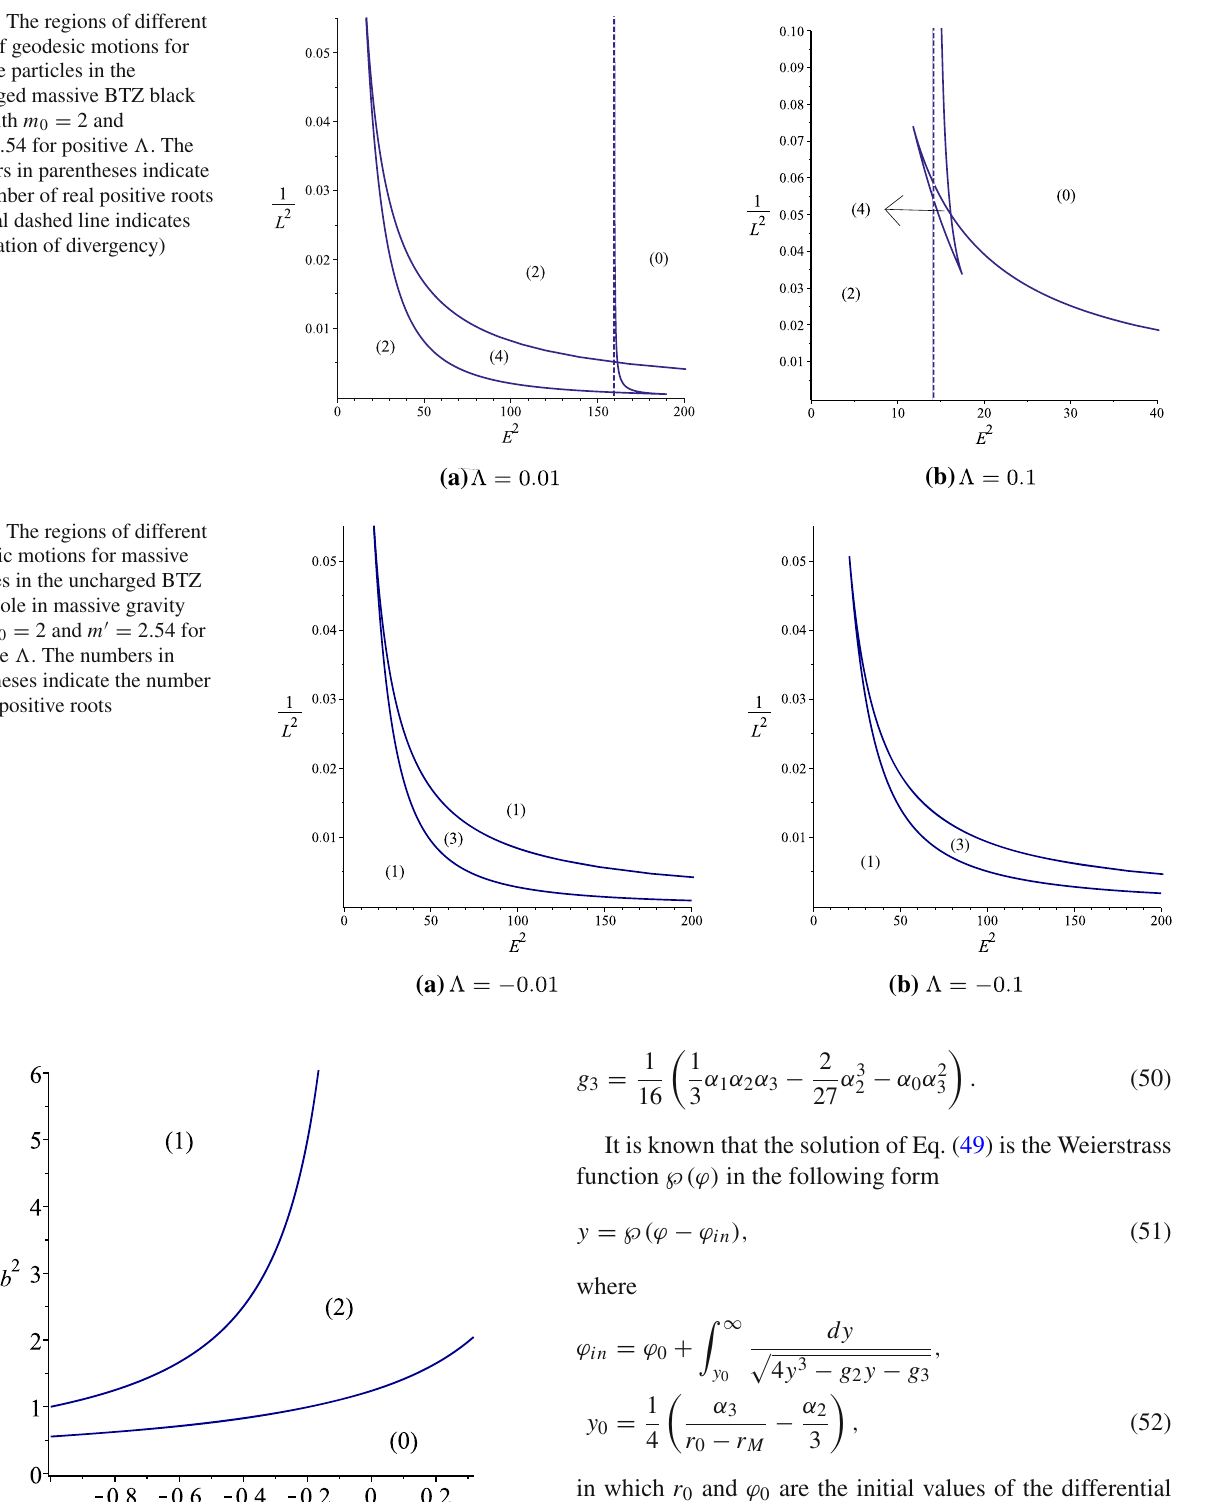
Fig. 8 Theregionsofdifferentgeodesicmotionsformasslessparticles in the uncharged BTZ black hole in massive gravity with m 0 = 2 and m (cid:5) = 2 . 54. The numbers in parentheses indicate the number of real positive